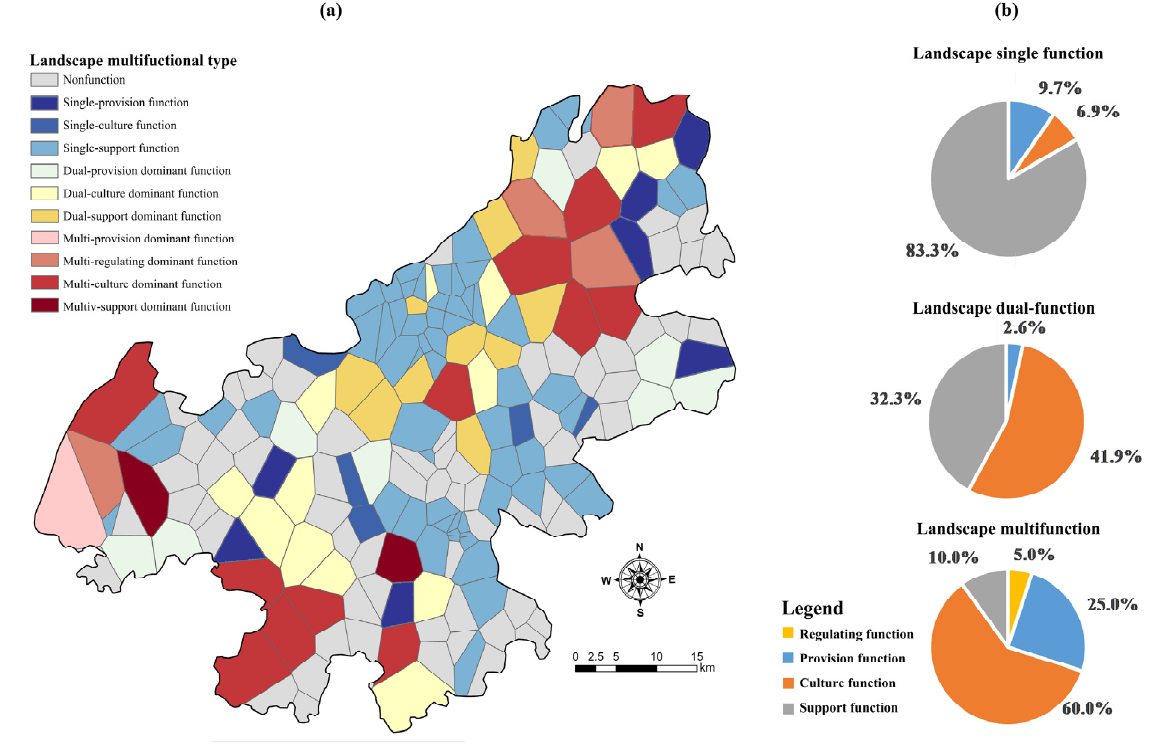
Figure 6. Identification and classification of dominant functions in rural communities. ( a ) Spatial distribution of dominant functions of each landscape multifunction type; ( b ) the proportion of each function in different landscape multifunctional type.